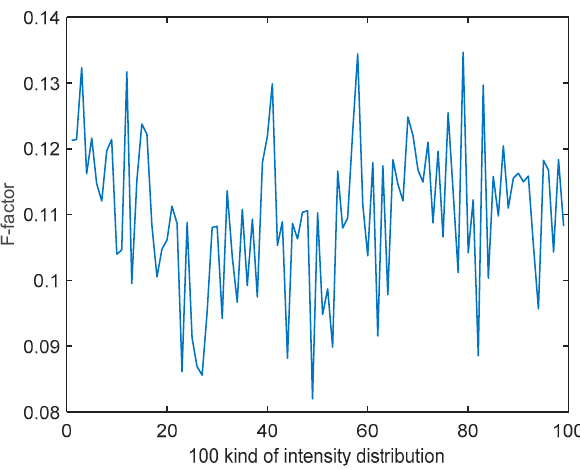
Figure 5. F-factor of 100 kinds of intensity distribution.